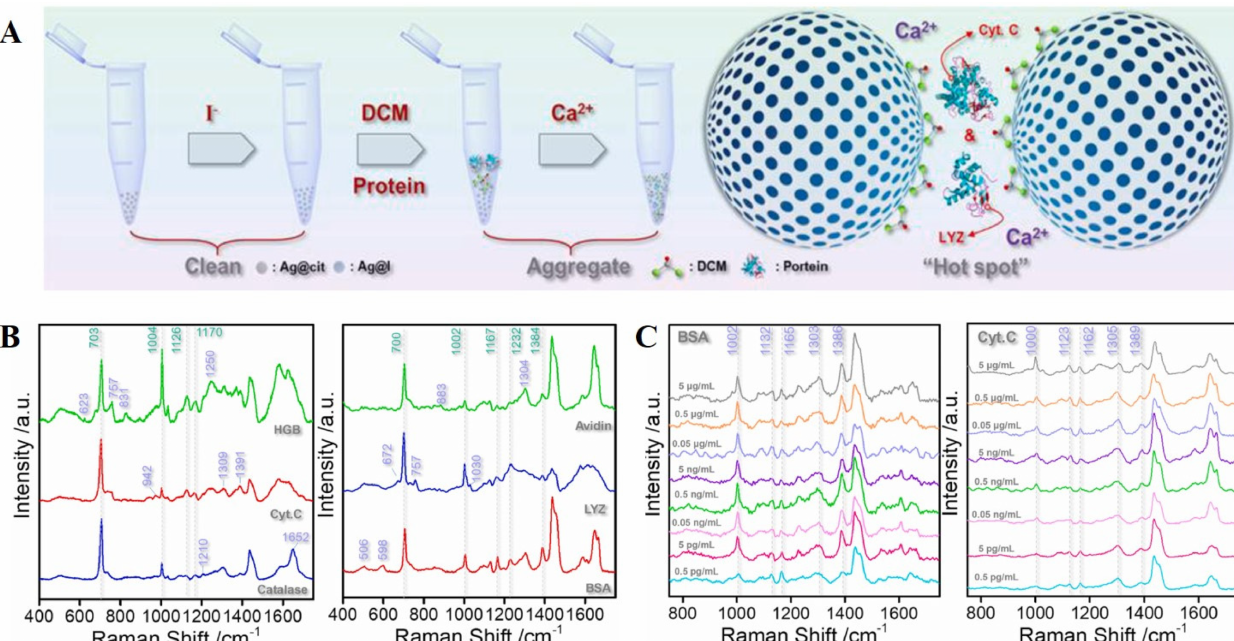
Figure 3. ( A ) Schematic diagram of a label-free SERS detection of proteins; ( B ) SERS spectra of three easily-detectable proteins (HGB, Cyt. C and Catalase) and three difficult-to-detect proteins (Avidin, LYZ and BSA); ( C ) SERS spectra of BSA and Cyt. C at different concentrations. Reprinted with permission from [18]. Copyright 2022 Elsevier